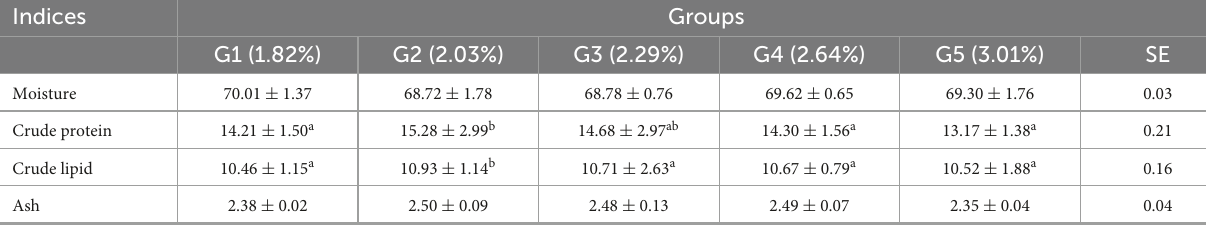
TABLE 6 Effects of dietary phenylalanine levels on the body composition of triploid O. mykiss . Indices Groups